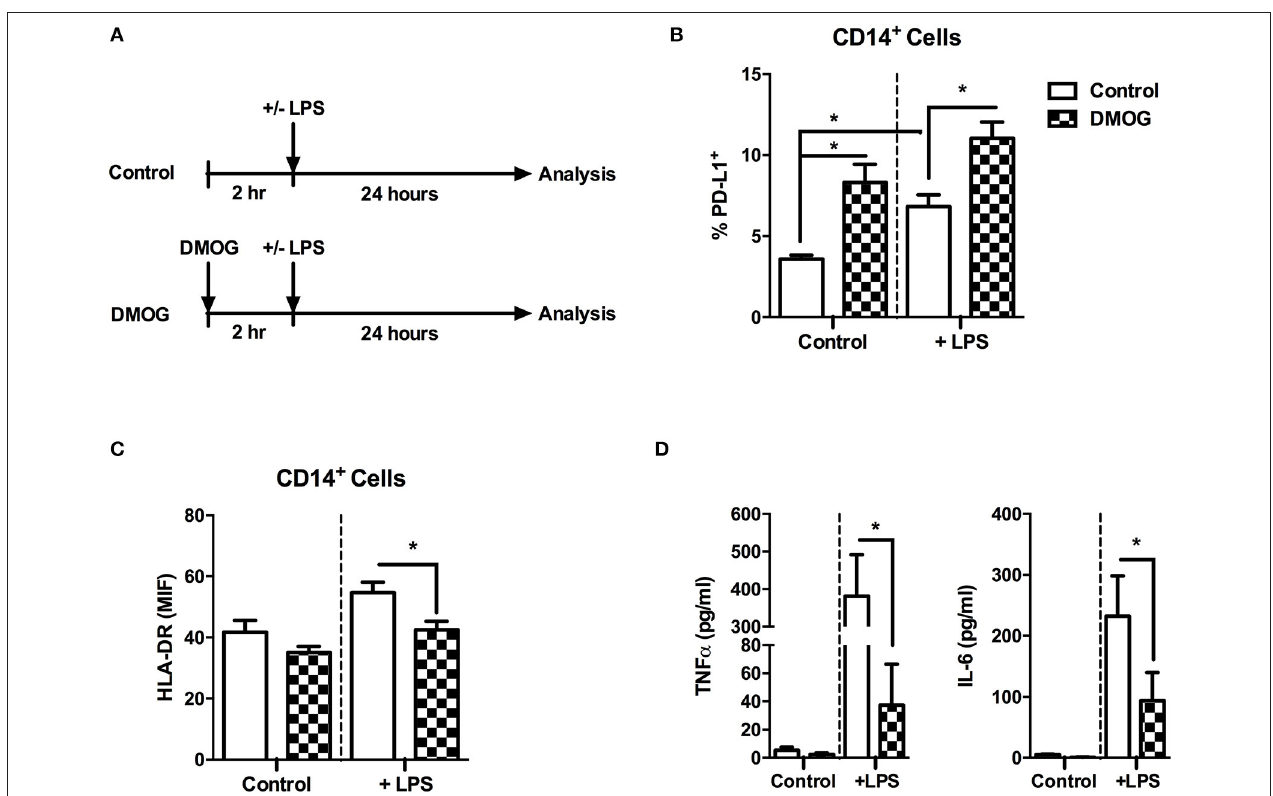
FIGURE 6 | PHDs inhibition with DMOG causes PD-L1 overexpression and impaired LPS response on healthy monocytes. Monocytes from HV were isolated by ficoll and plate adherence, and stimulated following the represented scheme (A) . (B) Percentages of PD-L1 + cells gated on CD14 + cells. (C) Mean intensity fluorescence of HLA-DR on gated CD14 + cells. (D) TNF α and IL-6 production (pg/mL) after 24h of in vitro LPS stimulation (10ng/mL). * p < 0.05 using a Student’s t -test.